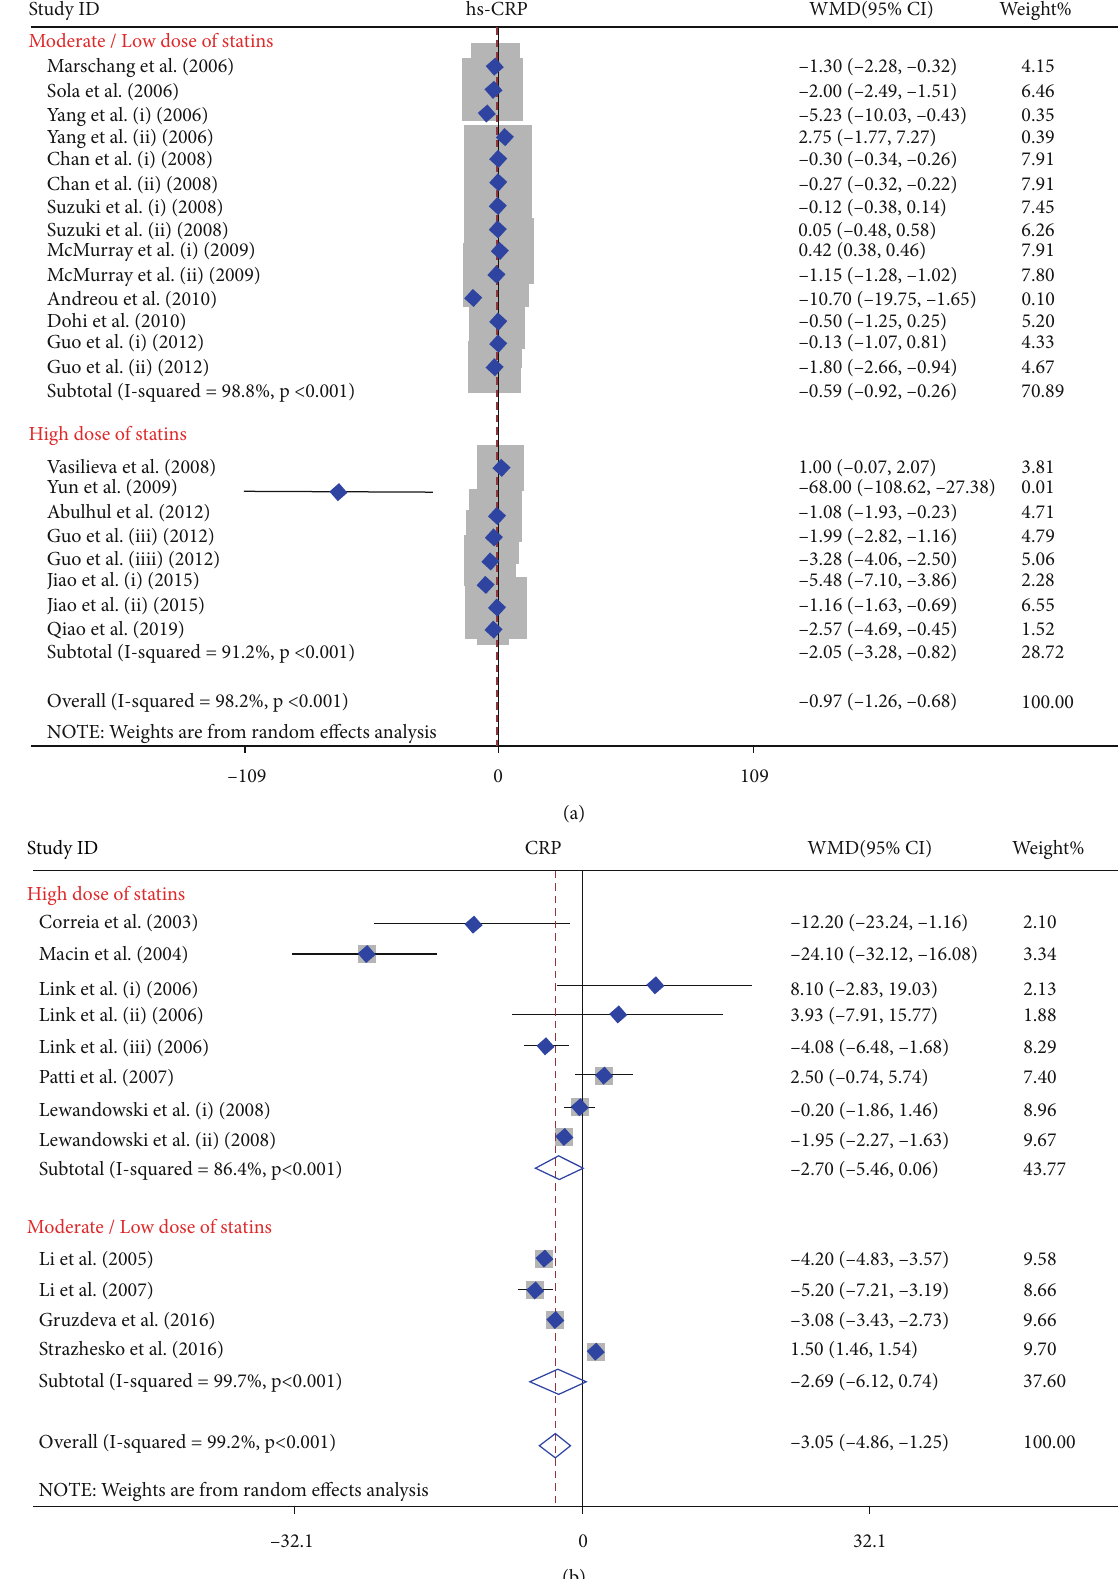
Figure 3: Forest plot presenting WMD and 95% CI for the e ff ect of statin administration on hs-CRP and CRP levels in subgroup analysis by dose; (a) hs-CRP and (b)